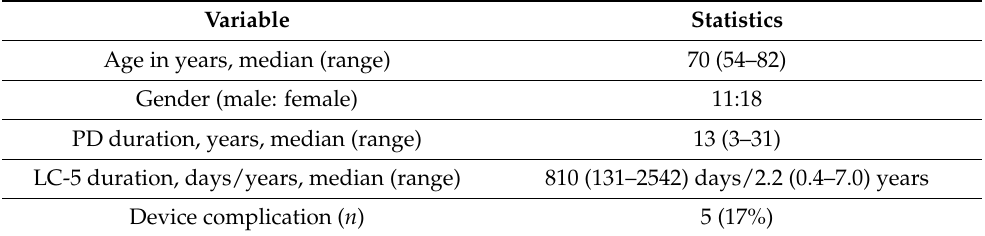
Table 1. Demographics based on data collected from medical records ( n = 29).